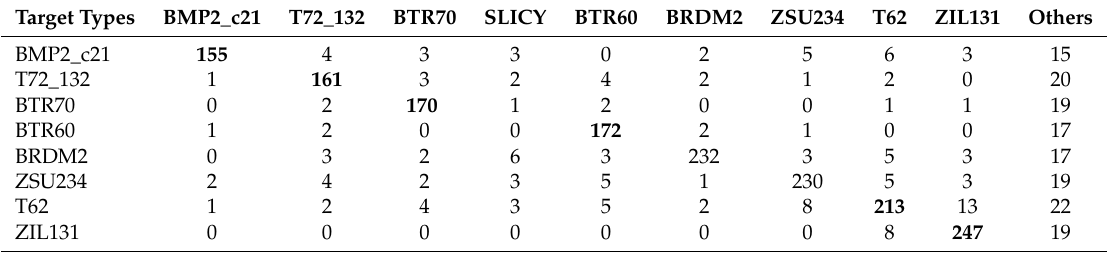
Table 5. Test results of the MIBL-HMM algorithm trained with 0.75 ◦ aperture multi-domain HRRP sequence. Target